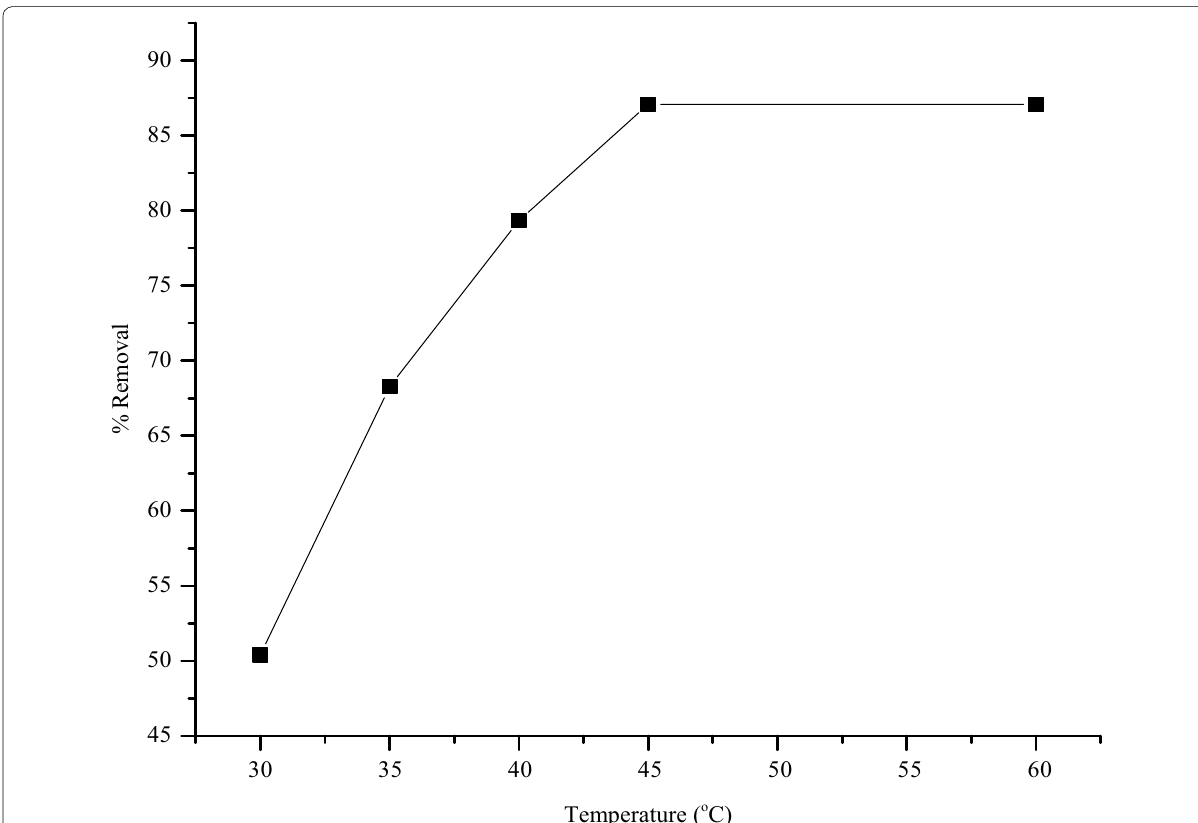
Fig. 5 Effects of temperature on the uptake of Cd(II) ions (initial contaminant concentration agitation time 120 =